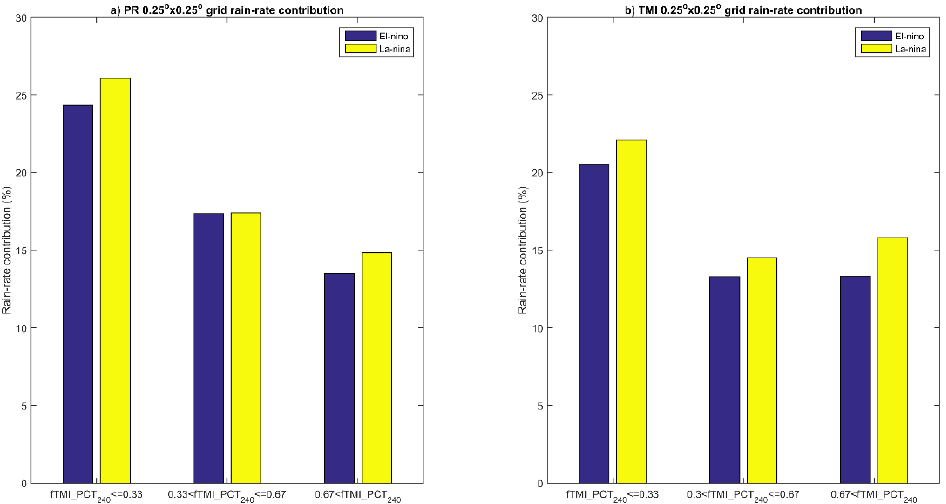
Figure 4. Comparison of PR rain-rate contribution ( a ) and TMI rain-rate contribution ( b ) for deep precipitation systems during El Niño events in 2007 and La Niña events in 2009 over the global tropical ocean. (Source: data processing).